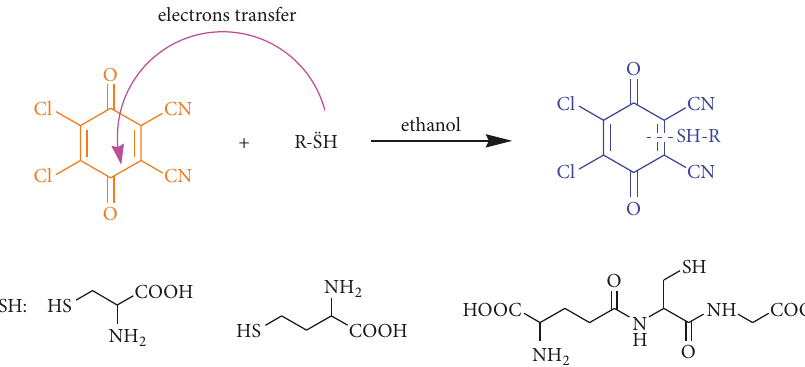
Scheme 1: Schematic illustration of the detection for biothiols of DDQ as a